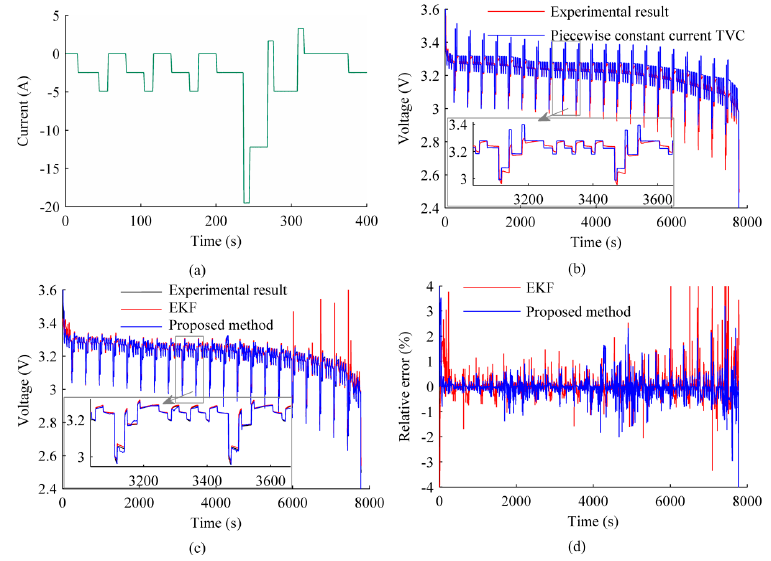
Figure 12. ( a ) Current curve (a cycle); ( b ) TVCs; ( c ) Modeling results and ( d ) Modeling error under DST.